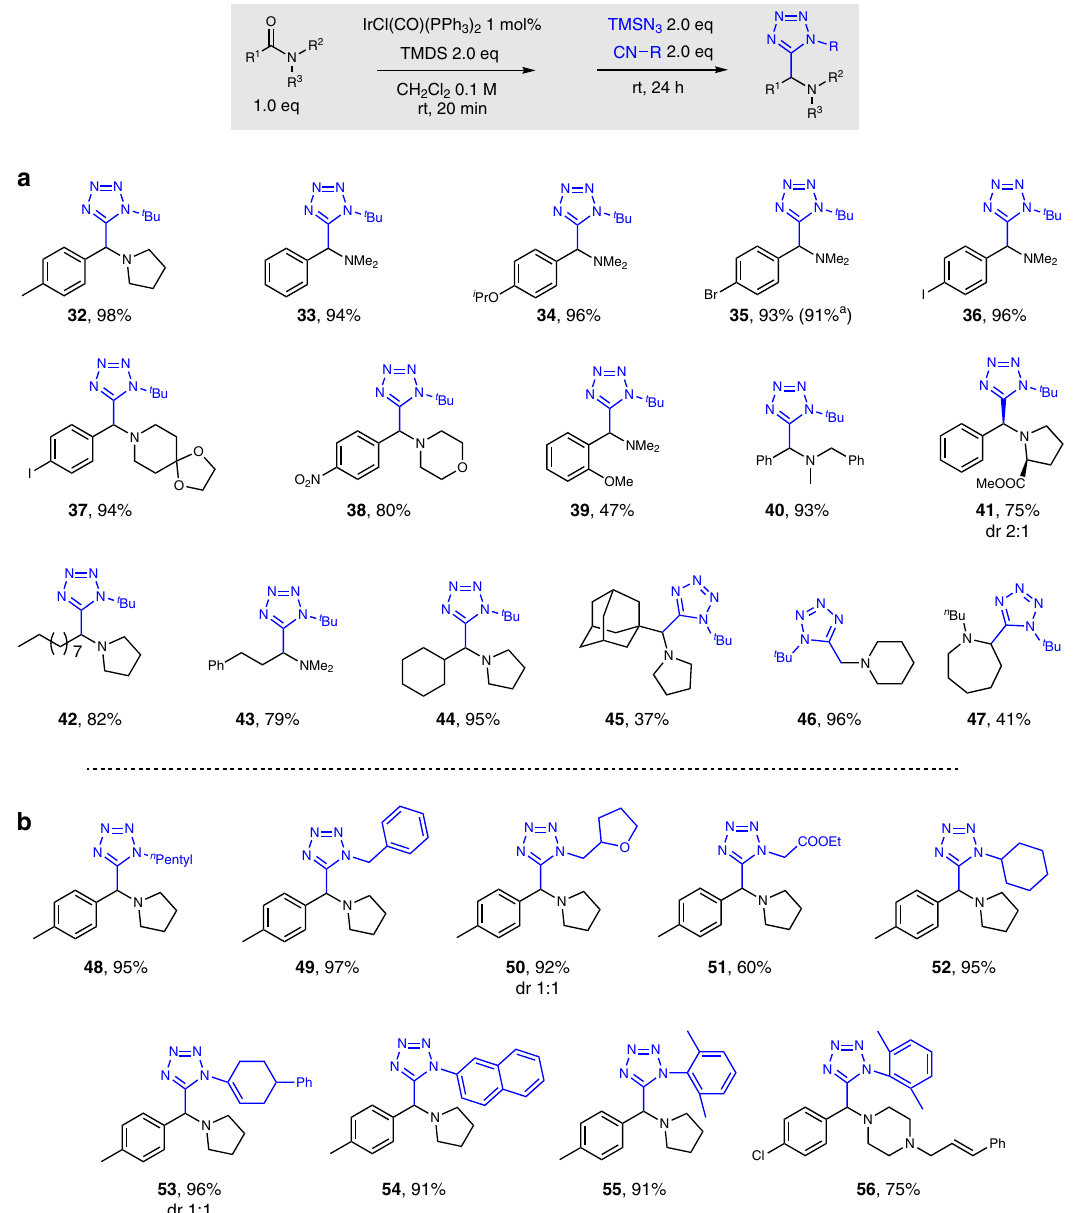
Fig. 4 Synthesis of α -amino tetrazoles. a Scope with respect to the tertiary amide. b Scope with respect to the isocyanide. Standard condition: amide 0.3 mmol, IrCl(CO)(PPh 3 ) 2 1 mol%, TMDS 0.6 mmol, CH 2 Cl 2 3 mL, isocyanide 0.6 mmol, trimethylsilyl azide 0.6 mmol; yields of puri fi ed product following fl ash column chromatography; a reaction was carried out with 1.14 g of